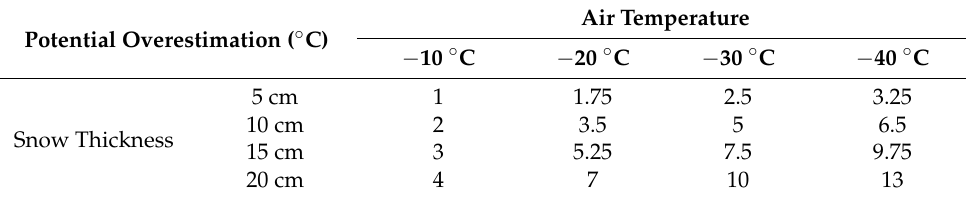
Table 6. The potential overestimation of surface temperature biases may be caused by snow cover when comparing the surface temperatures from the ERA with the surface temperatures measured by the IABP buoys.